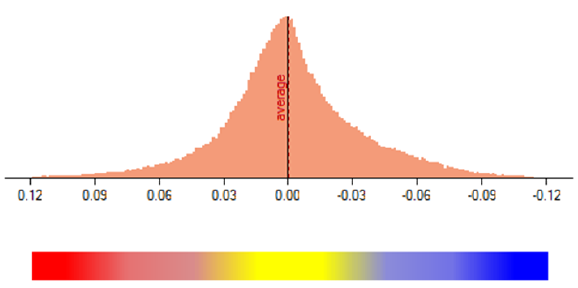
Figure 10. A diagram of the Gauss-Laplace distribution Fig. 11 shows the diagram of absolute deviations between vector models and the map color graduation of absolute deviations displayed in Fig. 9.